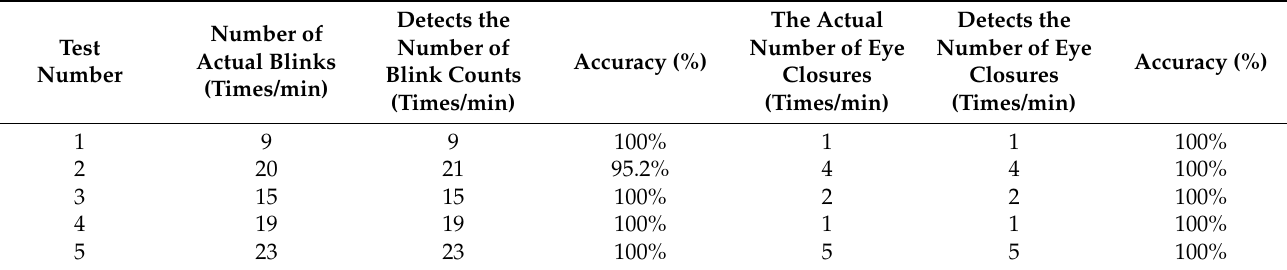
Table 4. Accuracy of eye fatigue index detection.